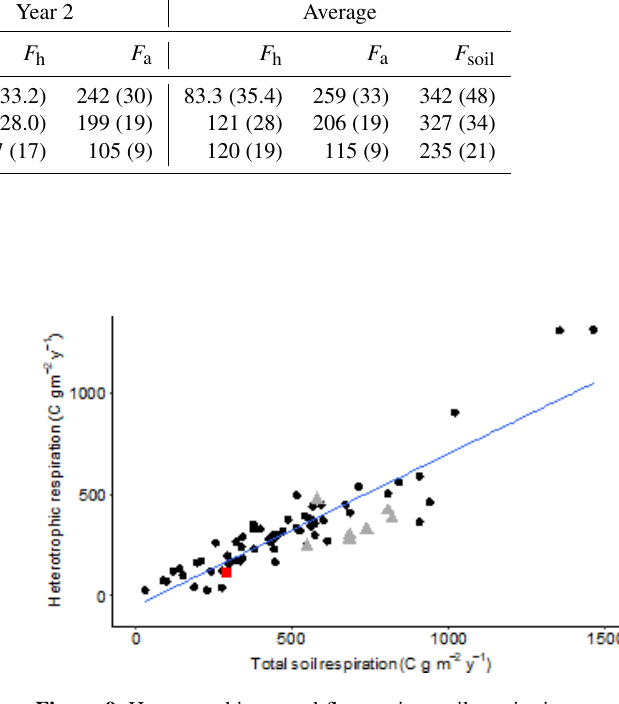
Figure 9. Heterotrophic annual flux against soil respiration annual flux (gCm − 2 yr − 1 ) in boreal forests in black dots and boreal forests on peat soils in grey triangles, from the Bond-Lamberty and Thom- son (2010) dynamic database downloaded on 19 April 2020. Our result of this study is added as the red square. See Table A1 in the Appendix for references to studies used to create this